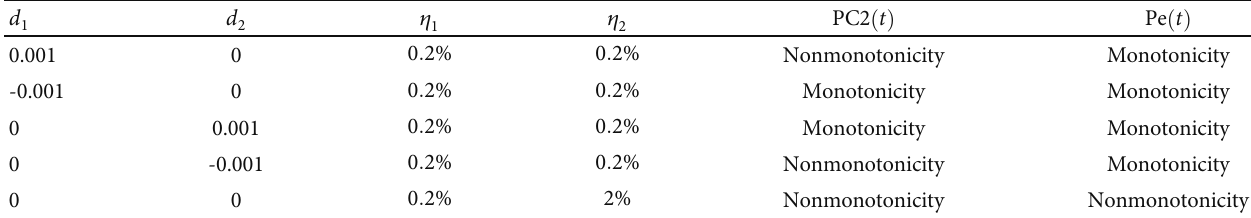
Table 1: Under closed-loop control, the characteristics of PC2 and Pe are